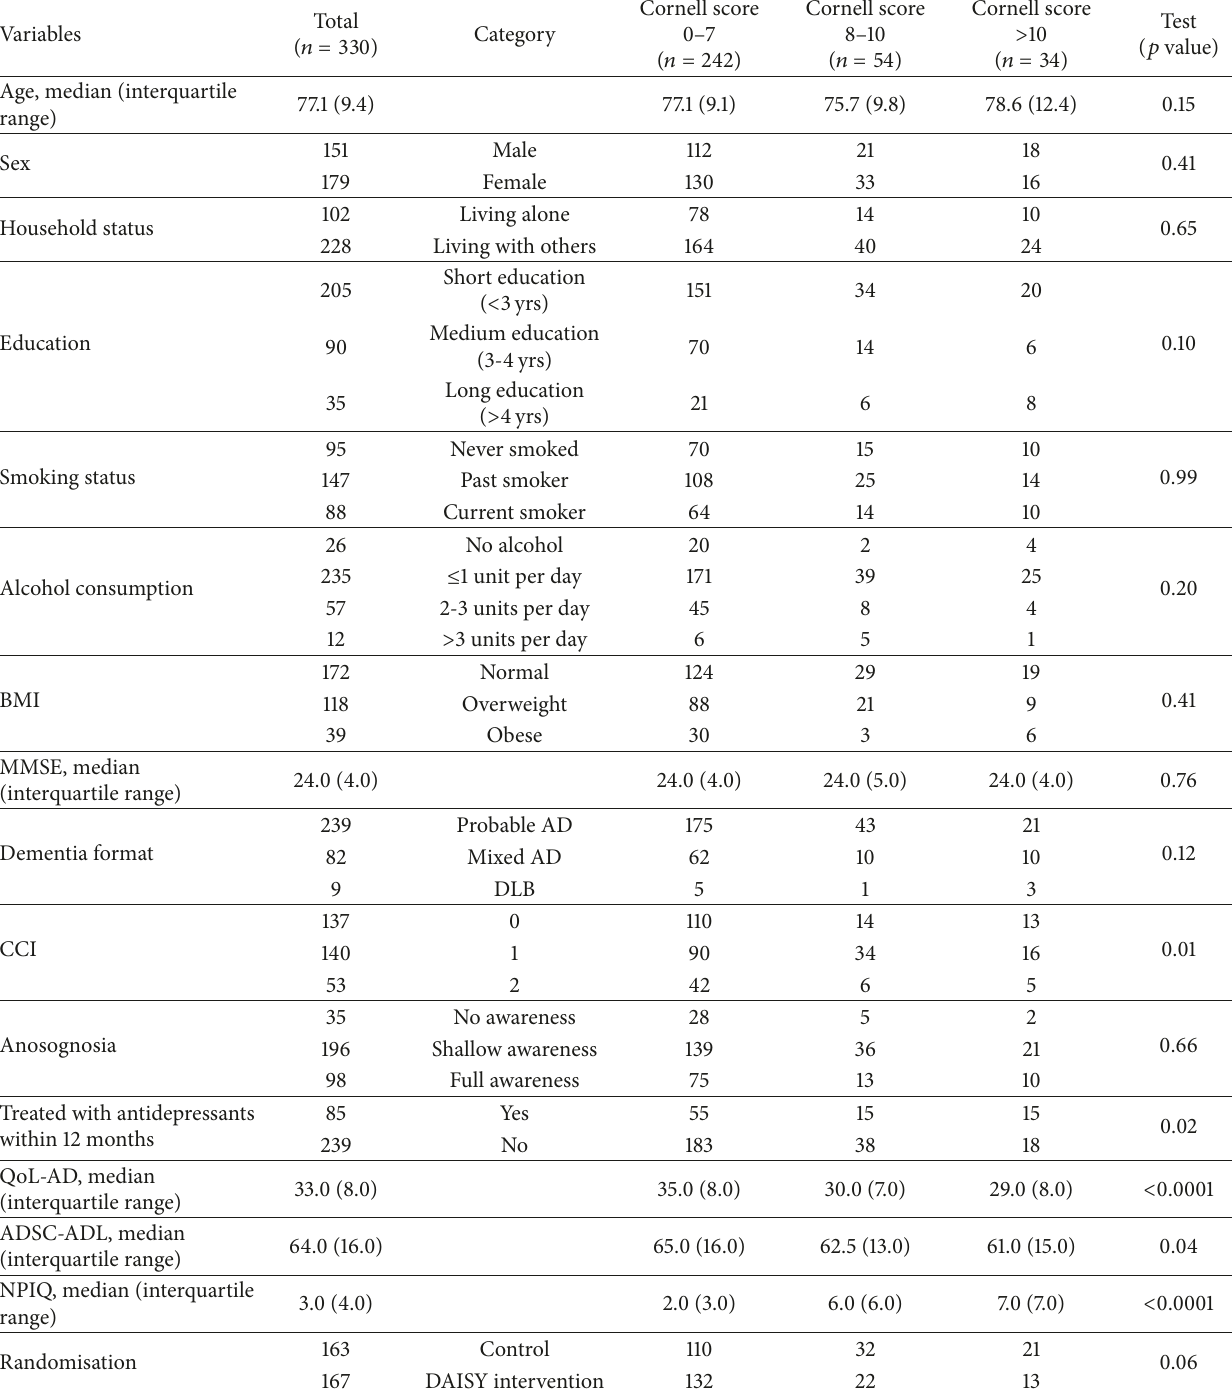
Table 1: Baseline characteristics of patients with mild dementia stratified by Cornell